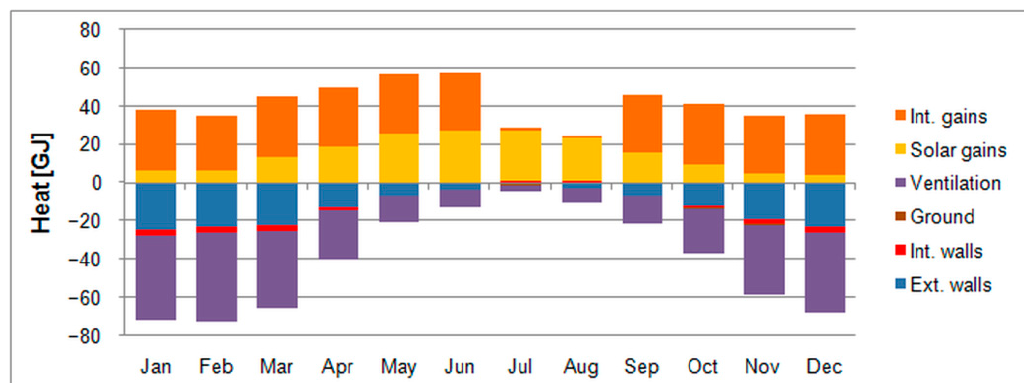
Figure 9. Heat gains and losses in the building after modernization.